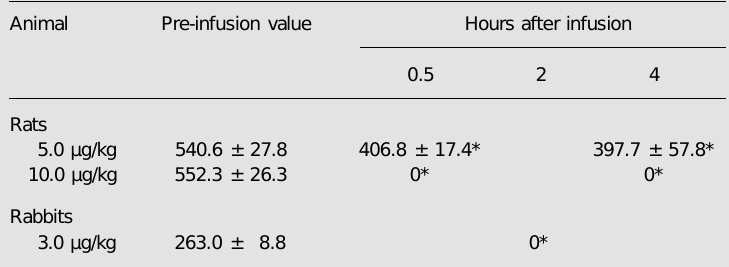
Table 3. Mean fibrinogen concentration in rat and rabbit plasmas after injection of Lonomia obliqua caterpillar bristle extract (LOCBE).